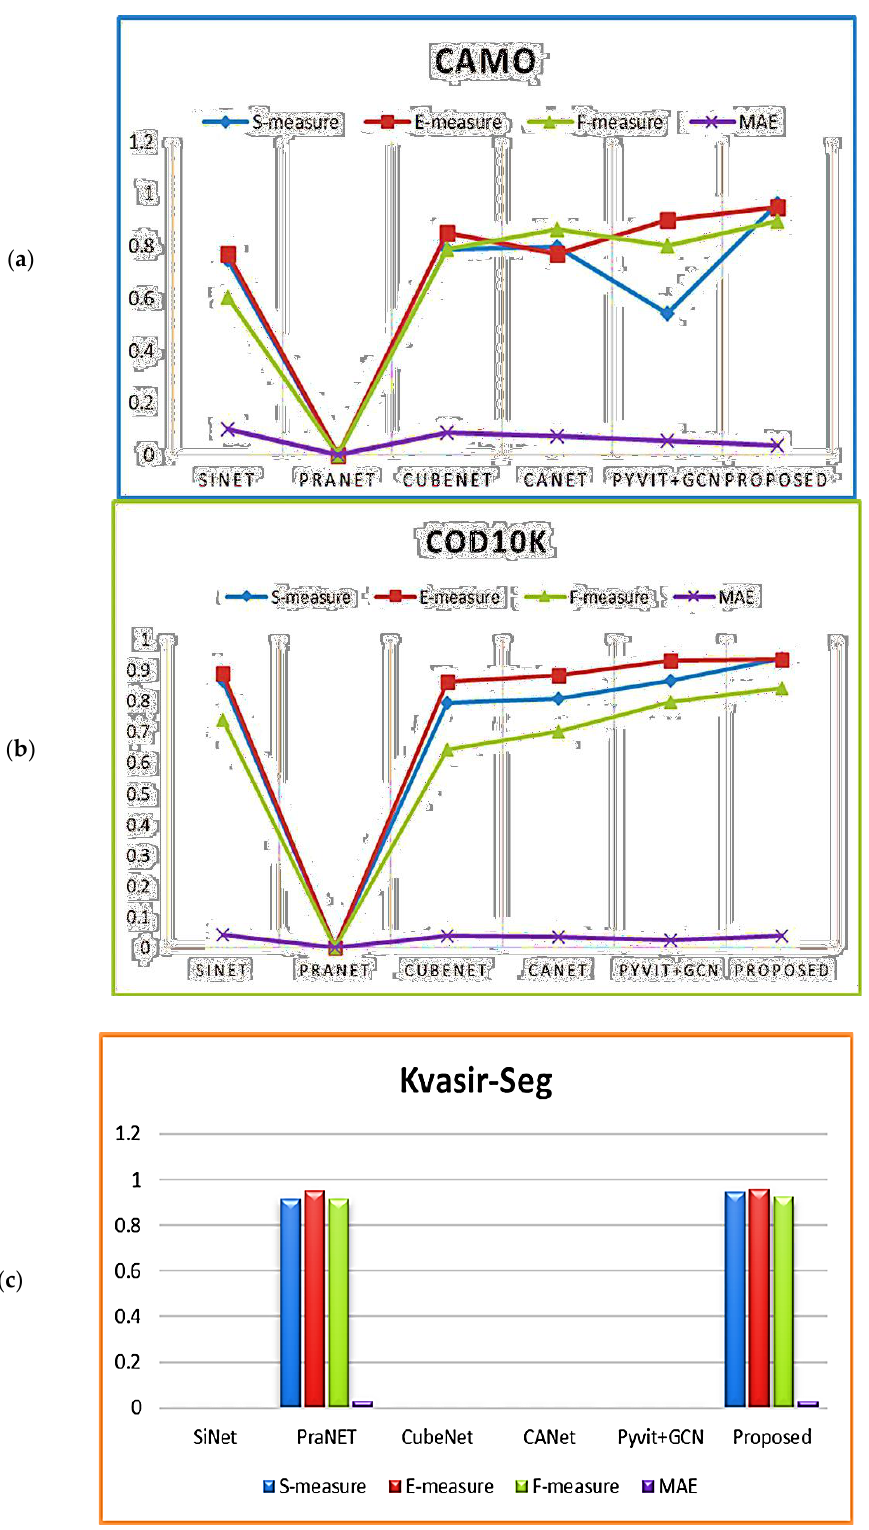
Figure 9. Comparative Analysis of multiple datasets: ( a ) CAMO; ( b ) COD10K; ( c ) Kvasir-SEG.